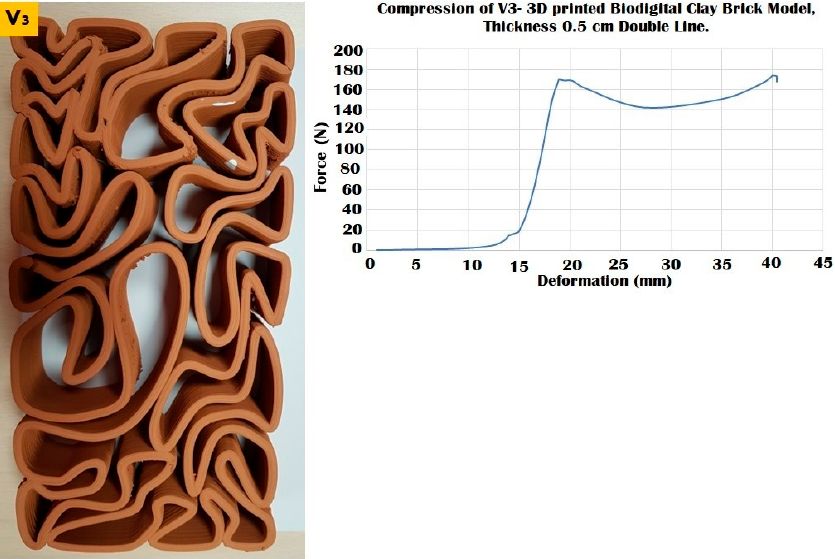
Figure 11. Exhibits the linear brick model of the V3 family of the biodigital clay bricks with double line linear thickness of 0.5 cm in the physical 3D-printed model ( left ). The graph exhibits the results of the compression test for the V3 linear model brick, showing the relation between force (N) ( Y -axis) and deformation (mm) ( X -axis) and achieving the maximum durability of this brick, resisting until 170 N before cracking and maintaining its resistance from 20 to 40 mm deformation under 140–170 N, before its collapse at 170 N, which is nearly 77% of the compression-resistance exhibited by the V1 bulk brick model and exceeding the compressive strength of the V1 linear model, while enduring the compressive force effect for a longer time and with higher value of compression reaching 40 mm before it totally collapsed.